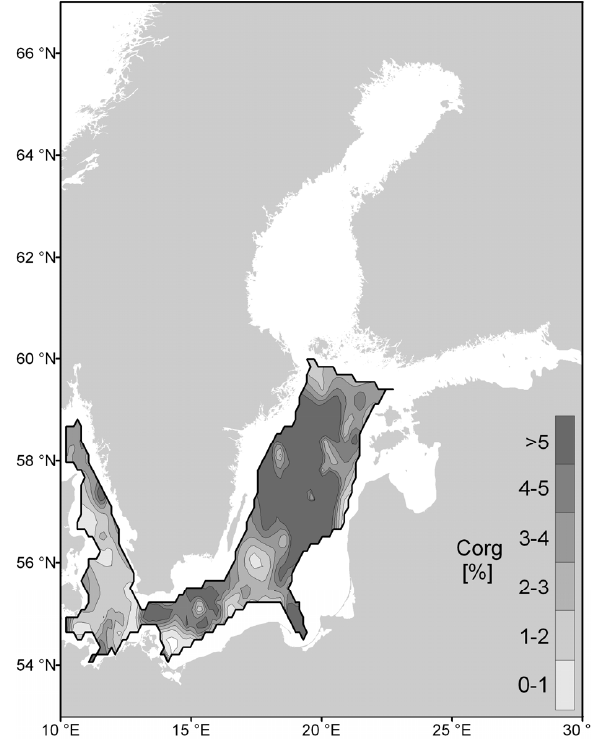
Figure 2: Map showing the C org [%] distribution for parts of the Baltic Sea. Fig. 2. Map showing the C org [%] distribution for parts of the Baltic